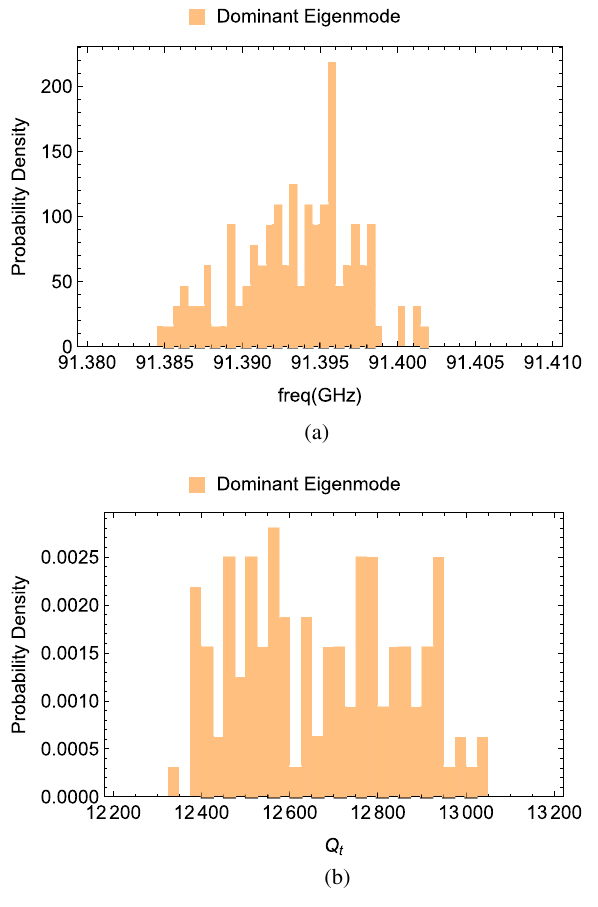
FIG. 13. rf undulator cavity longitudinal and transverse wake- fields from a 100 fs bunch, calculated with ECHO z2 . (a) Longi- tudinal wakefield and (b) transverse wakefield. Also shown in this figure is a linear fit around the bunch